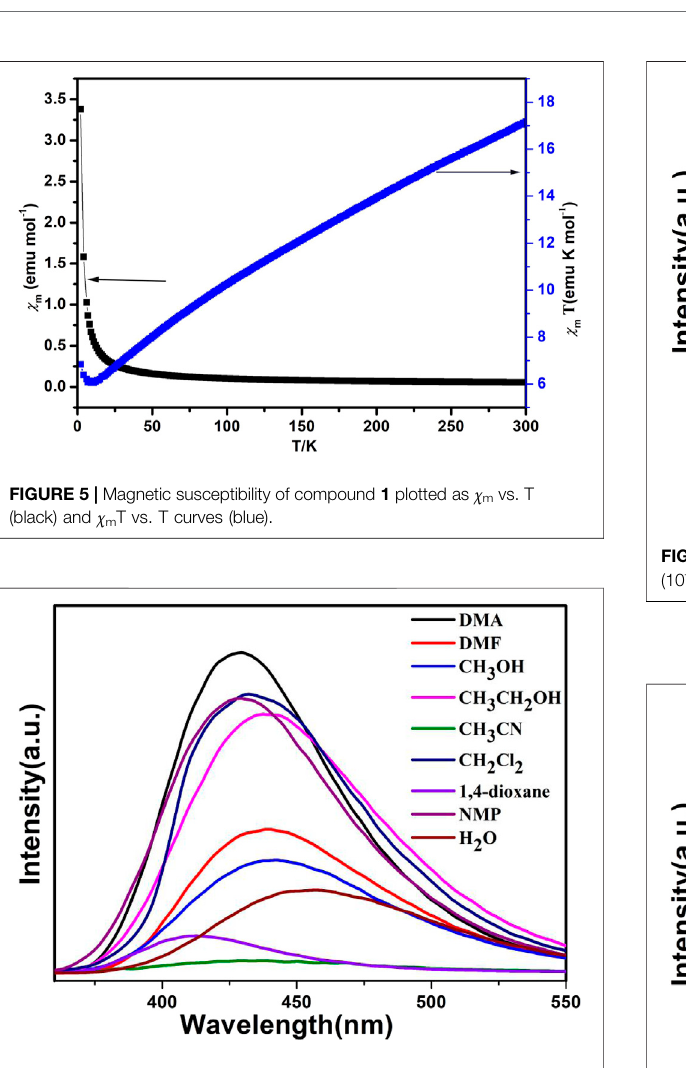
FIGURE 6 | Fluorescent spectra of compound 1a in different